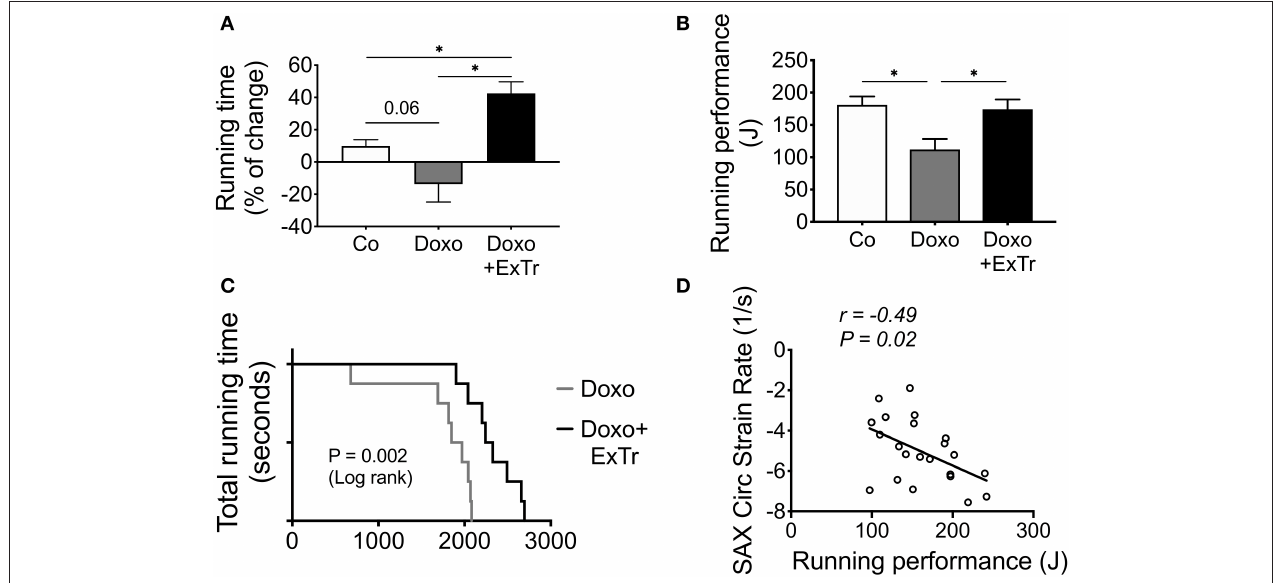
FIGURE 6 | ExTr blunts Doxo-induced effort intolerance. Effort tolerance, determined maximal running capacity, shows Doxo total running time from Baseline trend to impair (A) , and running performance (B) and total running time (C) were reduced. Interestingly, the better the cardiac contractility (strain rate), the higher is exercise capacity (D) among Doxo-treated groups. J, joule; SAX, short axis. Group abbreviations as in Figure 1 . n = 10–12 per group. * P ≤